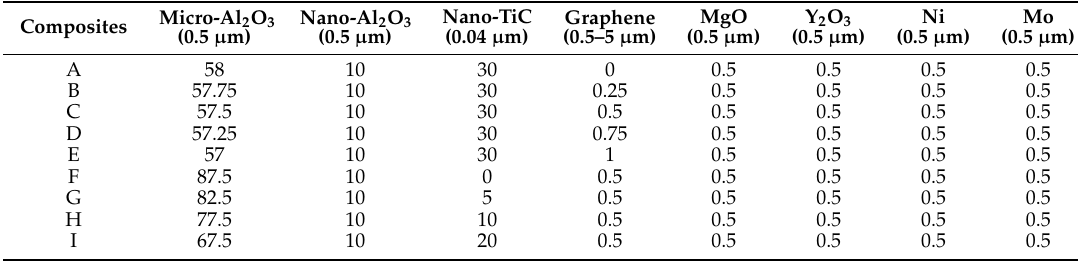
Table 1. Composition of composites (vol%).